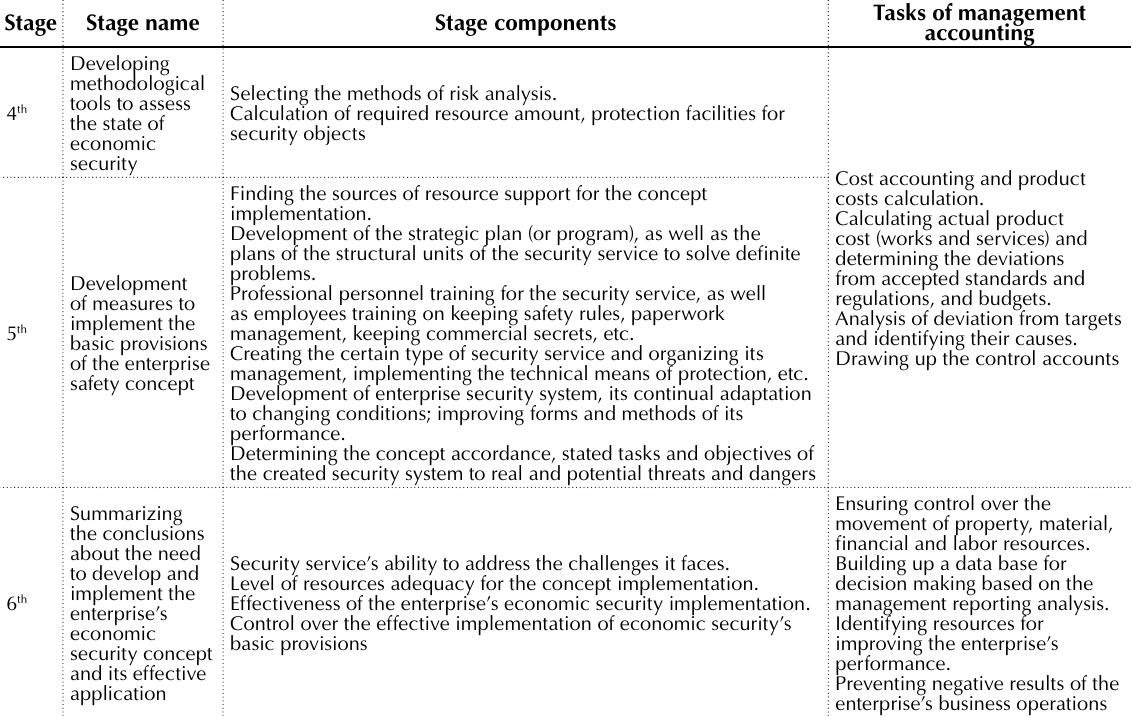
Table 1 (cont.). Stages of information support of the economic safety management system of an enterprise (in terms of management